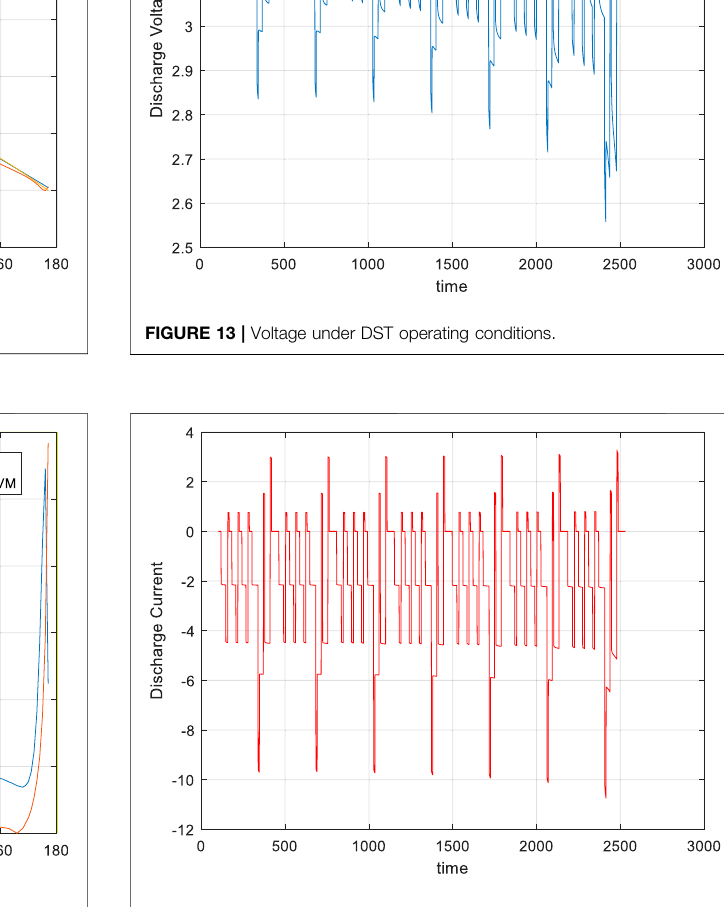
FIGURE 12 | The mean relative error of SOC of battery #2.